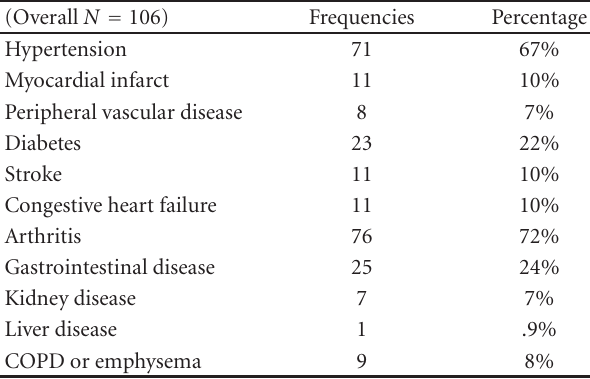
Table 3: Frequencies of health